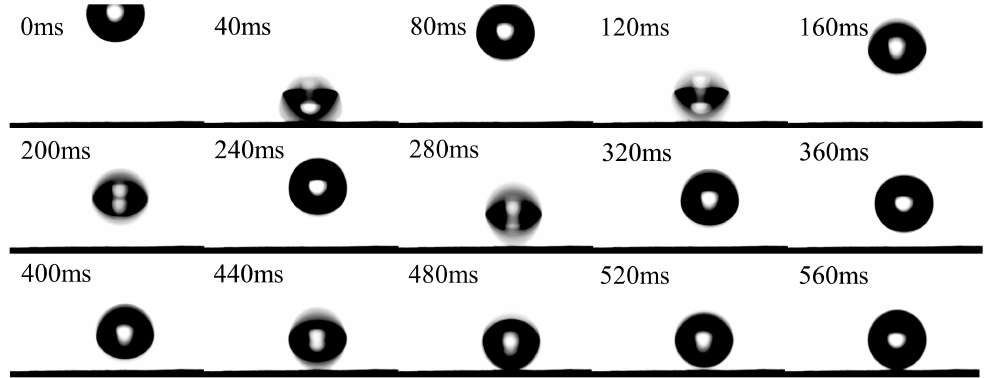
Figure 5. Bounce phenomenon of superhydrophobic Q235 carbon steel surface (5 μ L).